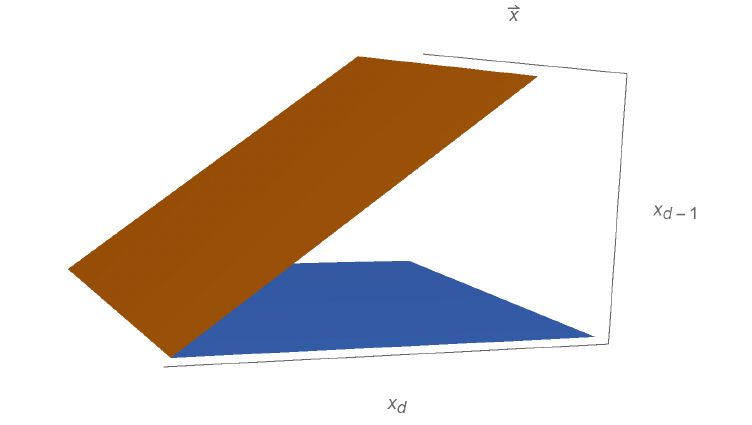
Figure 1 . An illustration of the setup we consider, where the blue plane is the wall, and the orange is the ramp. The wedge is the intersection of the two